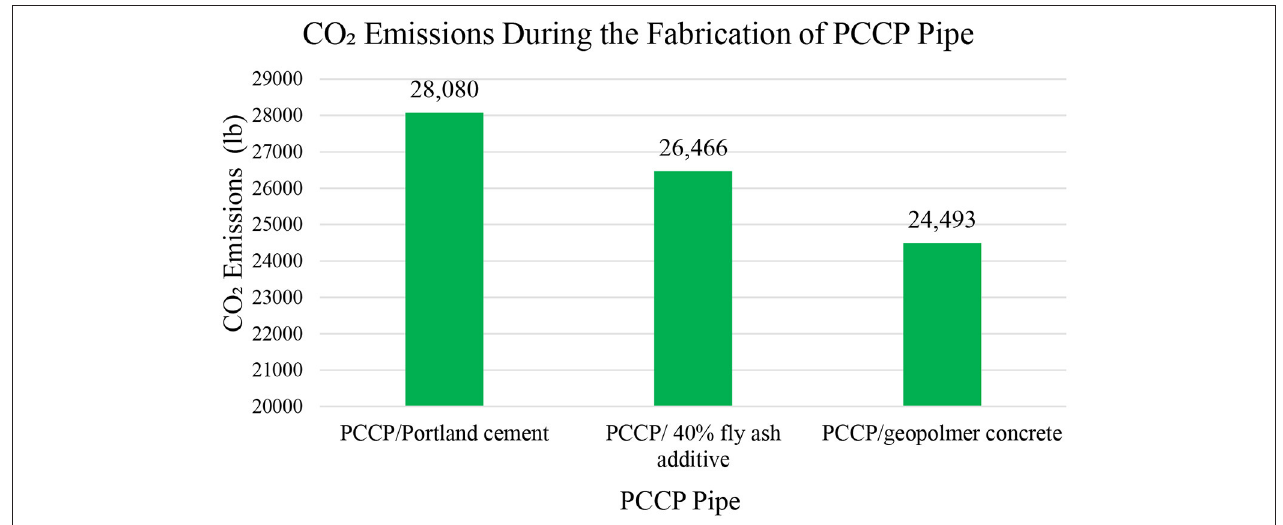
FIGURE 2 | Comparing the carbon emissions by using geopolymer concrete, flay ash additive and portland cement during the fabrication phase of PCCP pipe.